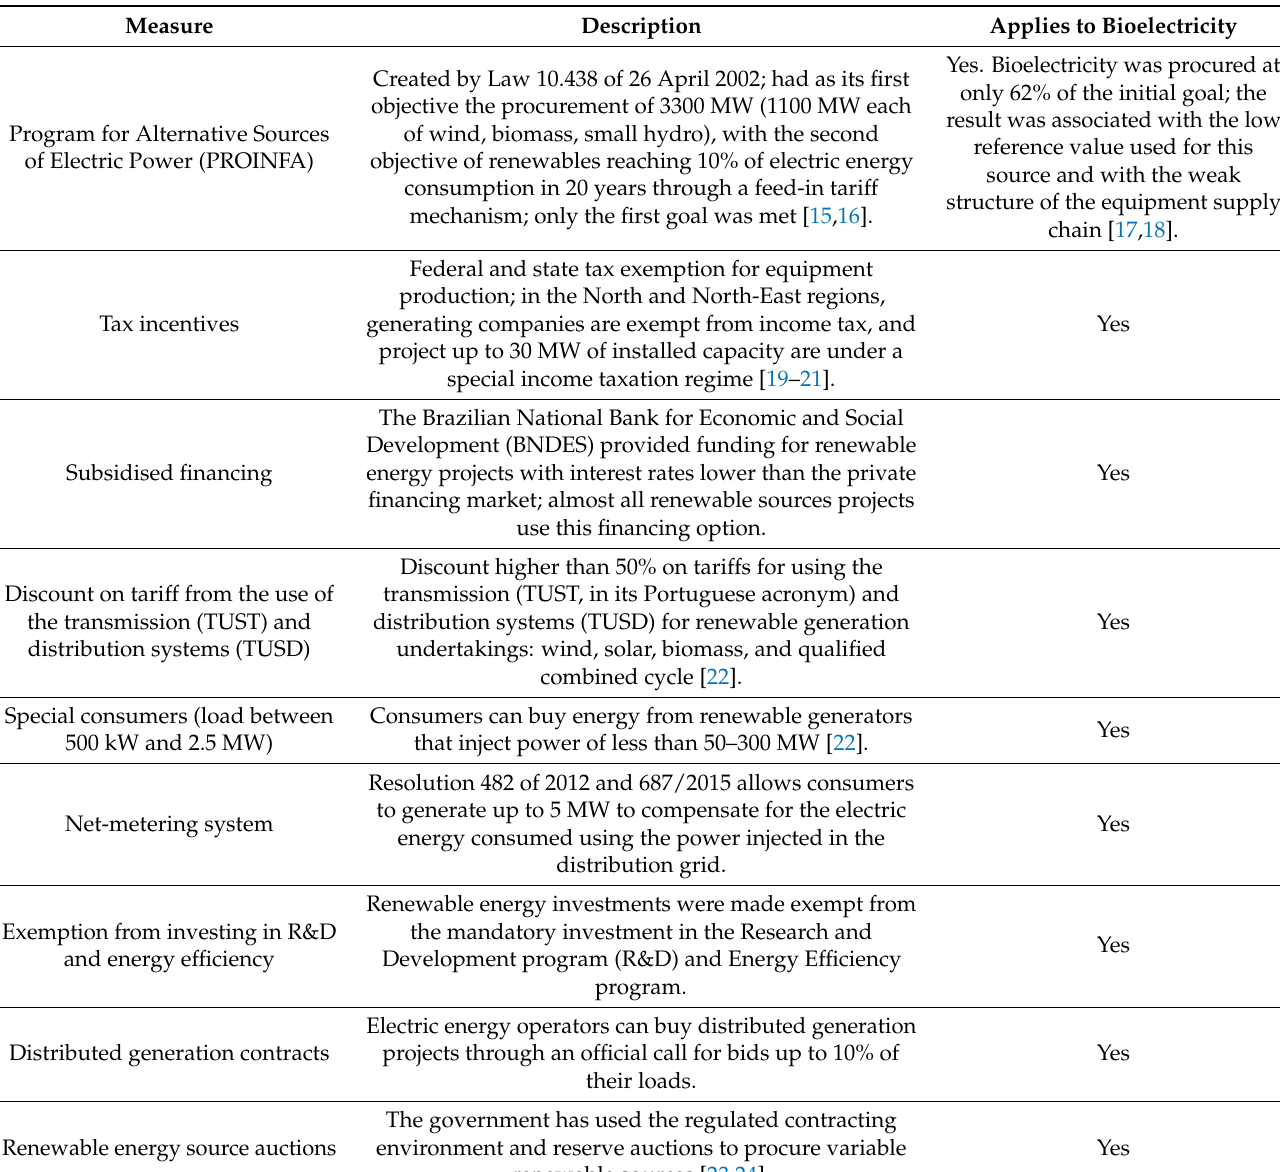
Table 1. Policies and incentives for variable renewable energy